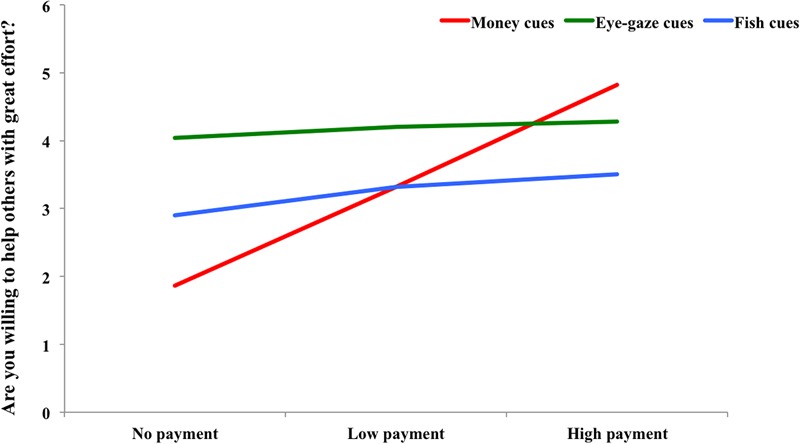
The line graph of the manipulation checks measure.